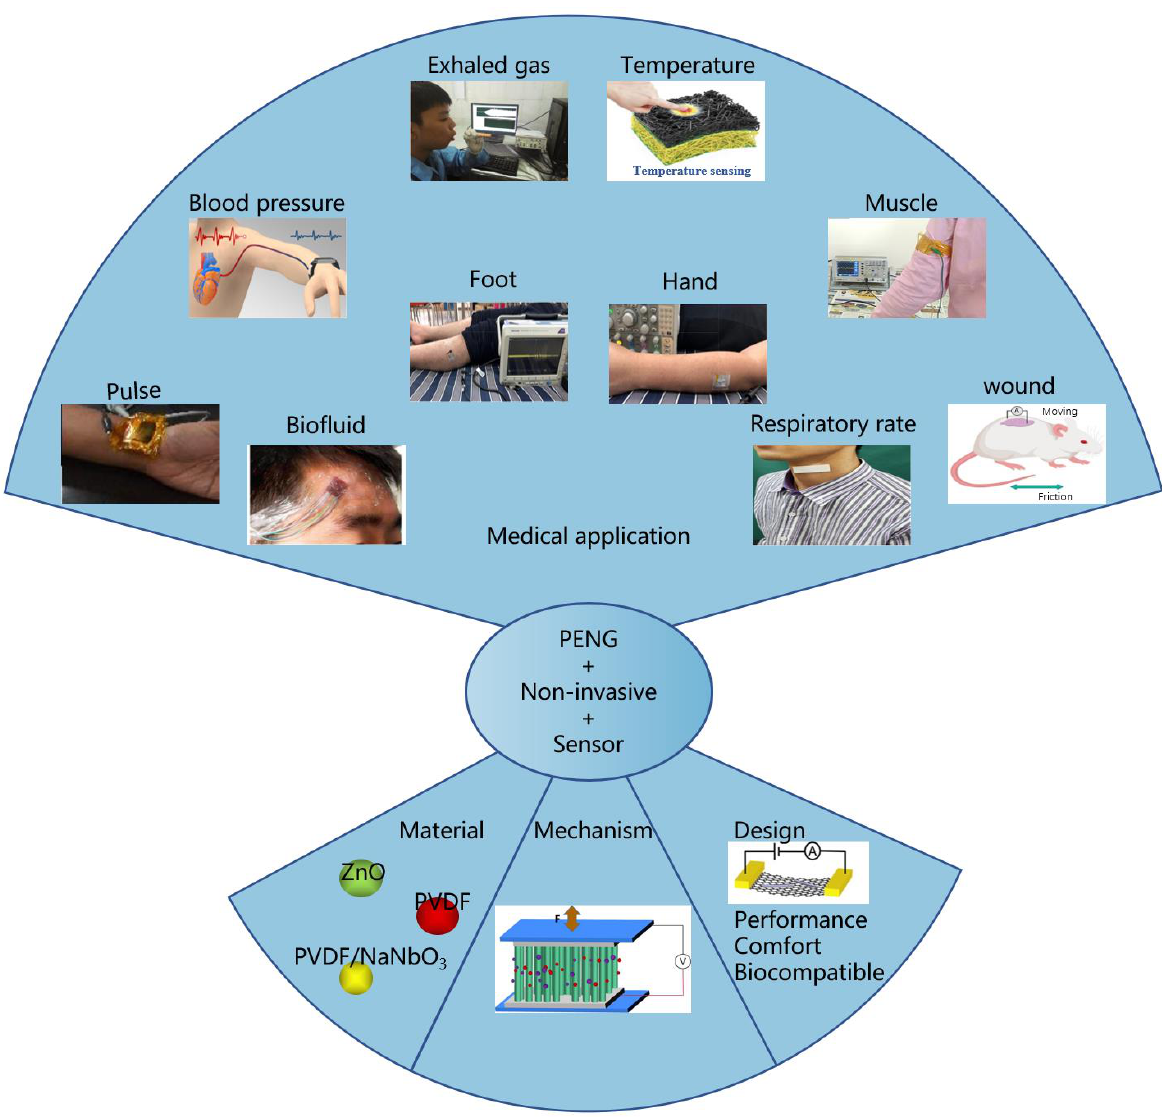
Figure 1. Recent progress in PENG-based non-invasive medical sensors, F is force, A is current meter, and V is